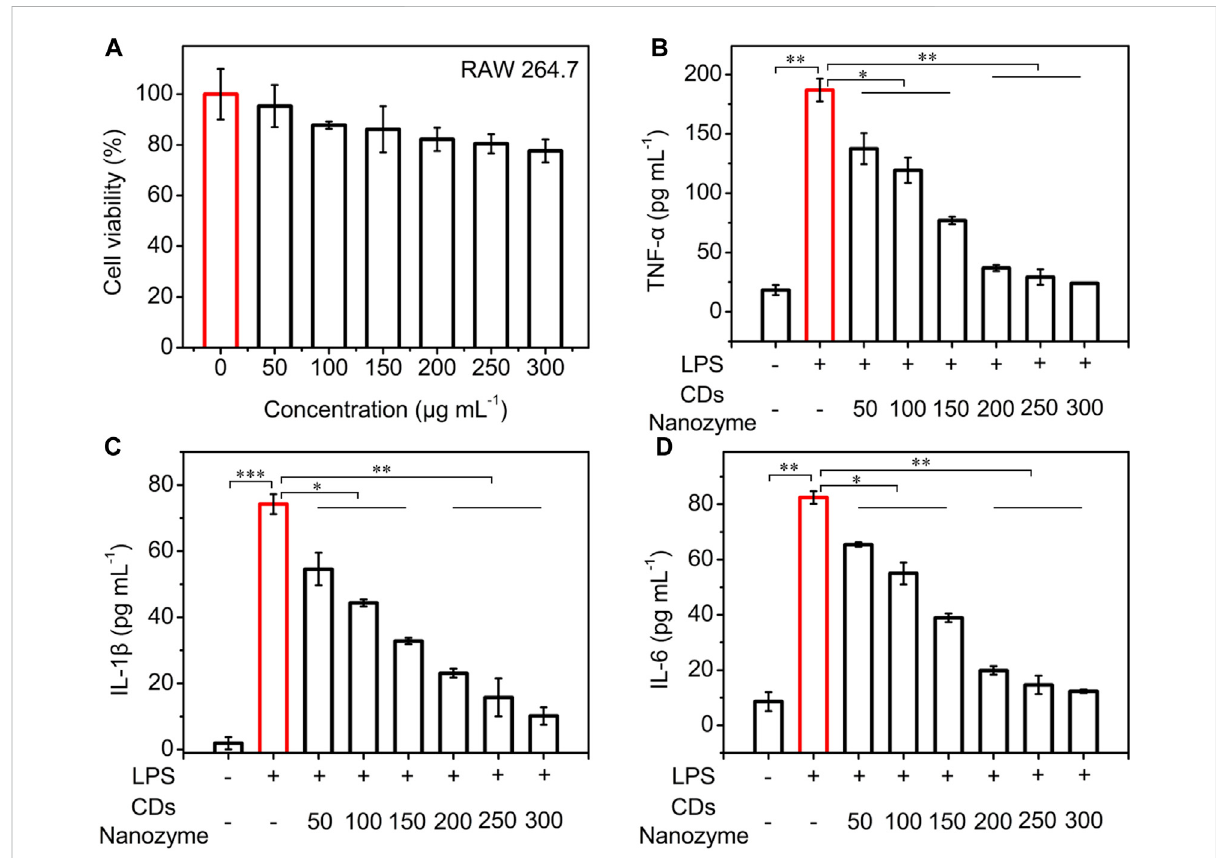
FIGURE 4 (A) Cell viability of RAW264.7 cells after treatment with various concentrations of CDs nanozyme for 24 h. (B) The TNF- α , (C) IL-1 β , and (D) IL-6 level of the supernatants of RAW264.7 macrophages after various treatments. The concentration of LPS is 1 μ g ml − 1